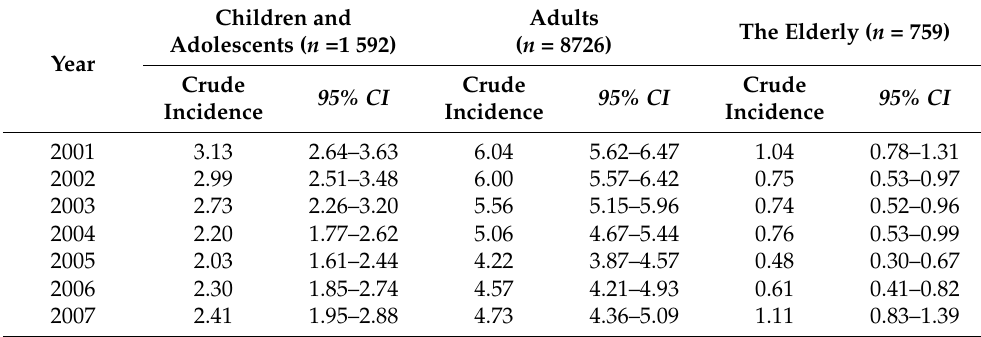
Figure 1. Crude rates of medical treatment over the years for victims of violence and abuse in three generations: Children and Adolescents, Adults, and The Elderly. Table 1. Crude rates of first-time medical treatment for Children and Adolescents, Adults, and The Elderly.